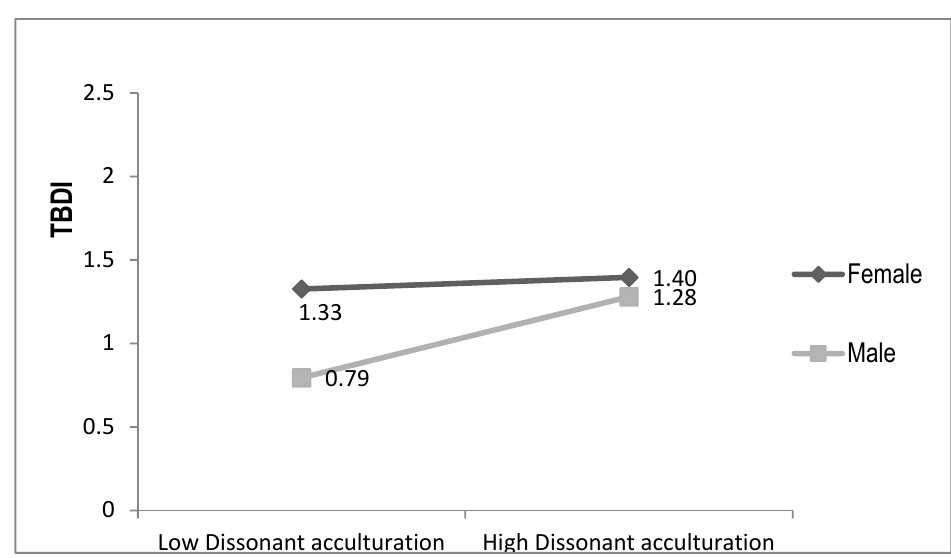
Figure 4. Dissonant Acculturation by Gender Explaining Distress.